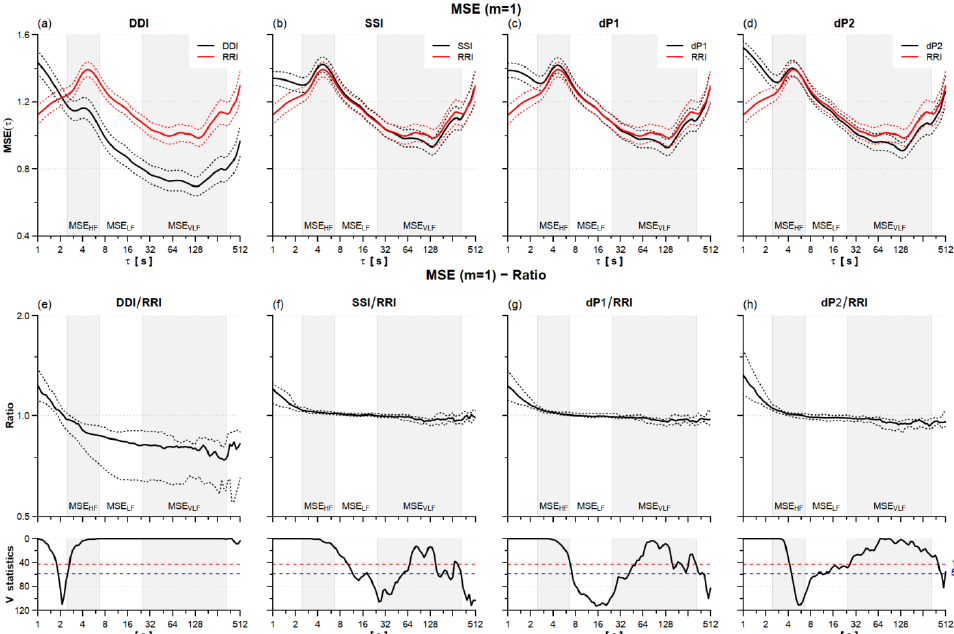
Figure 5. HRV multiscale entropy (MSE) for m = 1 sleeping at high altitude. Upper panels: mean (solid line) ± standard error (dotted line) for MSE of DDI, SSI, dP1, and dP2 (black) and the RRI reference (red) on n = 21 participants (panels ( a – d )). Lower panels: MSE ratio between DDI ( e ), SSI ( f ), dP1 ( g ), and dP2 ( h ) tachograms and the RRI reference: median (solid line) with 1st and 3rd quartiles (dotted line) and V-statistics of the Wilcoxon’s rank test; at the scales where V is above the 5% (or 1%) significance threshold (dashed horizontal line) the ratio differs from 1 at the 5% (or 1%) statistical significance. Grey/white areas indicate the scales for evaluating MSE HF , MSE LF and MSE VLF.